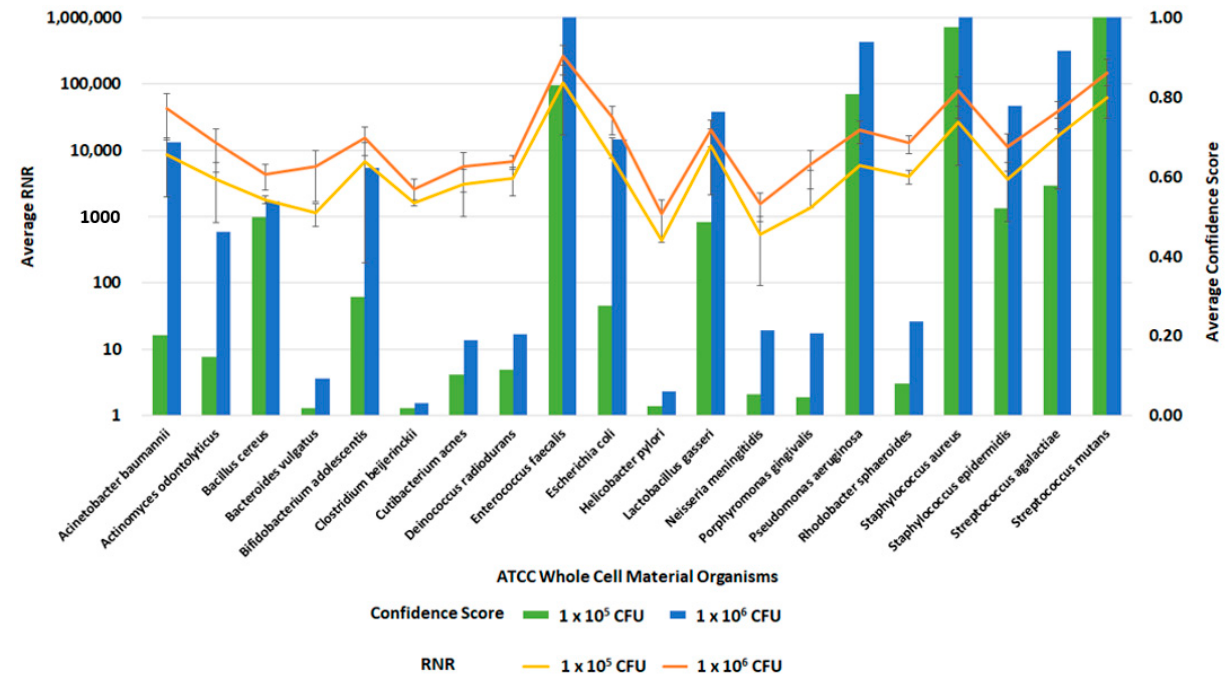
Figure 12. Inclusivity of ATCC Whole Cell Material Microbiome Standard—Whole Blood. This figure summarizes the average RNR and Confidence Scores based on 4 of 4 contrived, whole blood replicate samples. Bars represent sample confidence scores, and lines represent sample RNR values. At 1 × 10 5 CFU/ mL, the following were detected with less than 4 replicates: C. acnes (3), P. gingivalis (3), B. vulgatus (2), C. beijerinckii (2), N. meningitides (2), R. sphaeroides (2), H. pylori (1), P. aeruginosa (1).